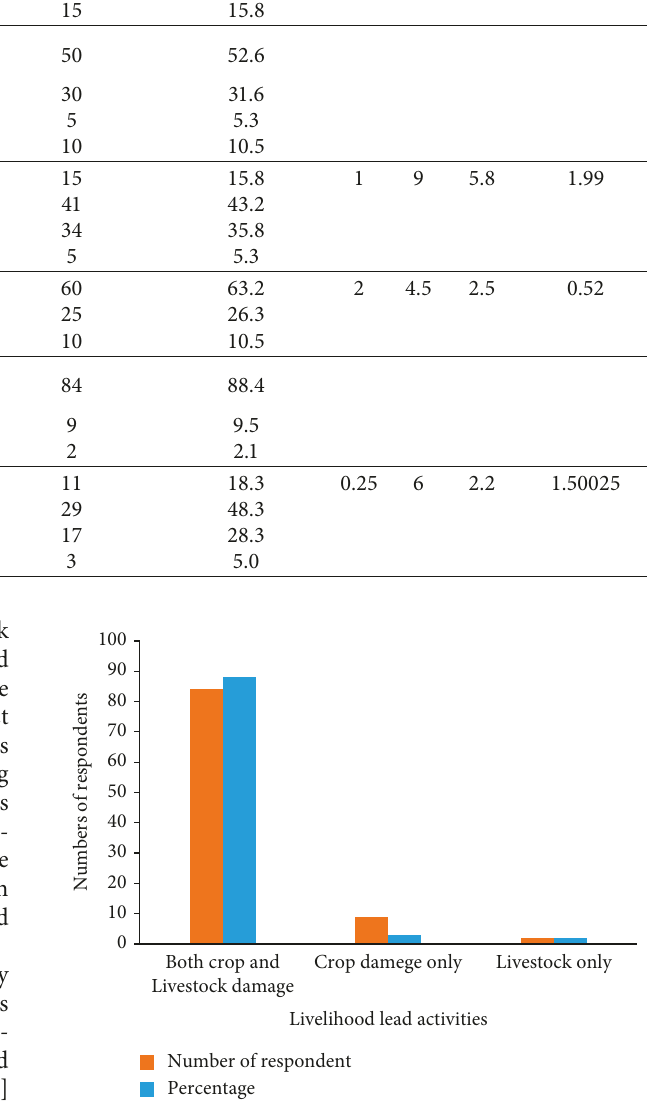
Figure 2: Effect of wild animals on the livelihood of local people in the study